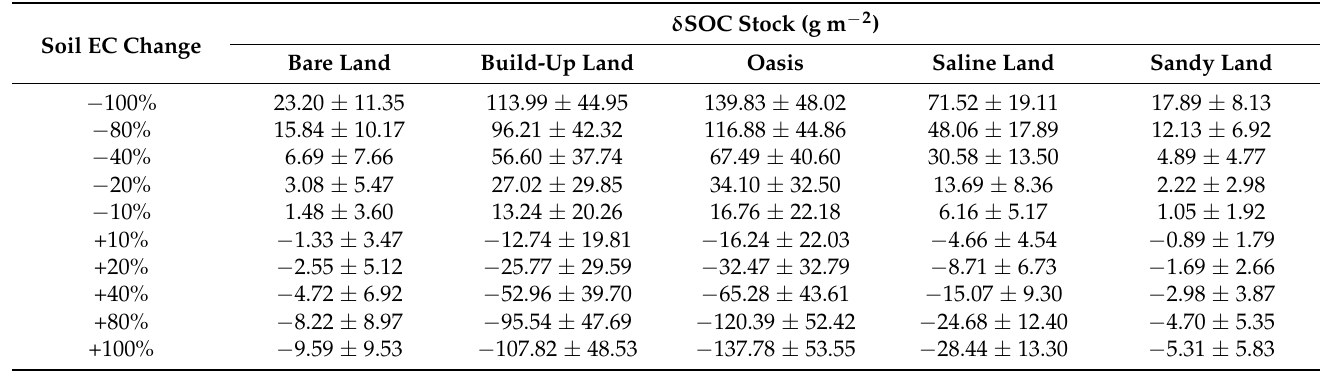
Table 3. Summary of the area-weighted averages and standard deviations of SOC stock differences ( δ SOC stock) by land use and land cover type under different salinity change